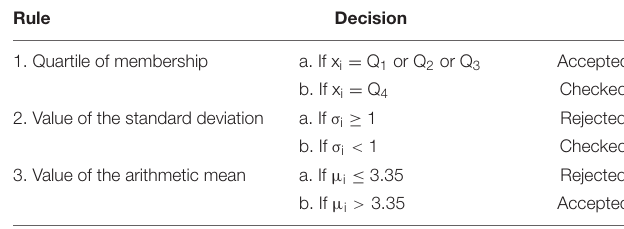
TABLE 2 | Criteria for selection of